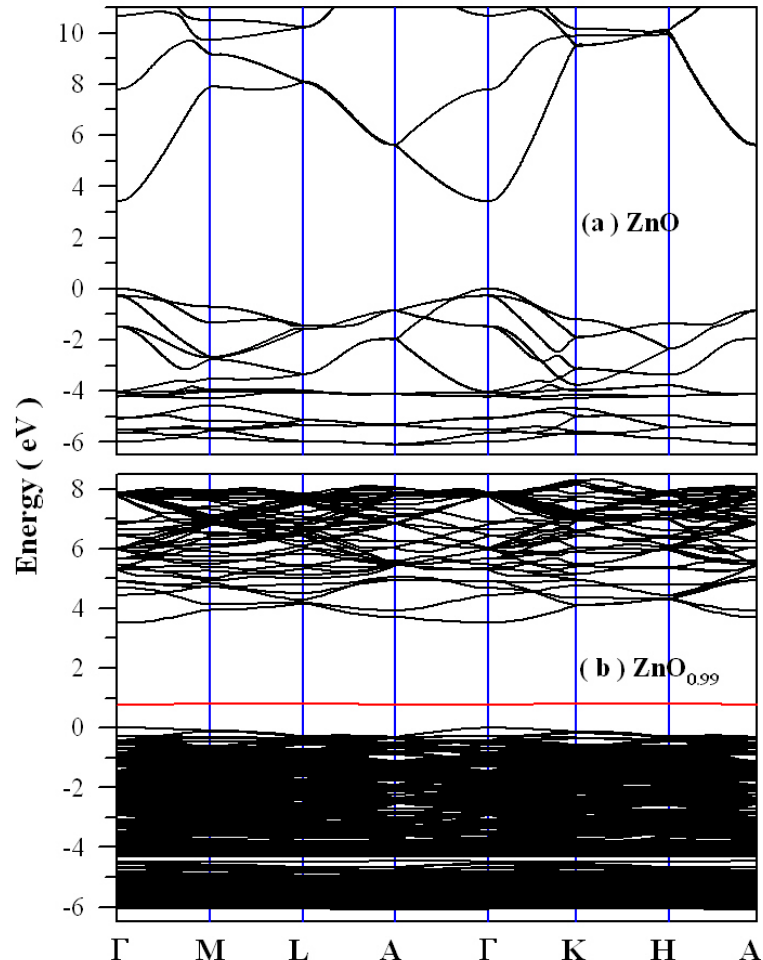
Figure 7. Density functional calculated band structures of perfect ZnO ( a ) and oxygen-deficient ZnO ( b